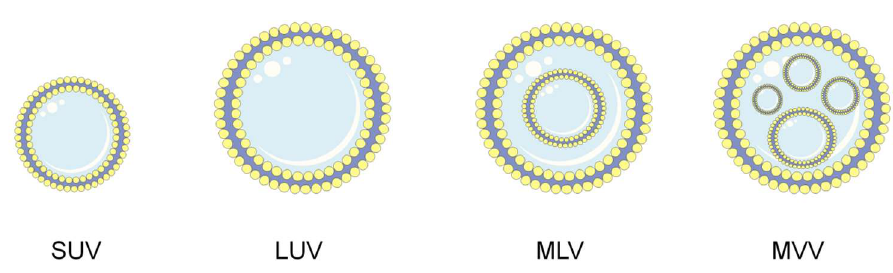
Figure 2. Types of liposomes: SUV—small unilamellar vesicles, LUV—large unilamellar vesicles, MLV—multilamellar large vesicles, MVV—multilamellar large vesicles.